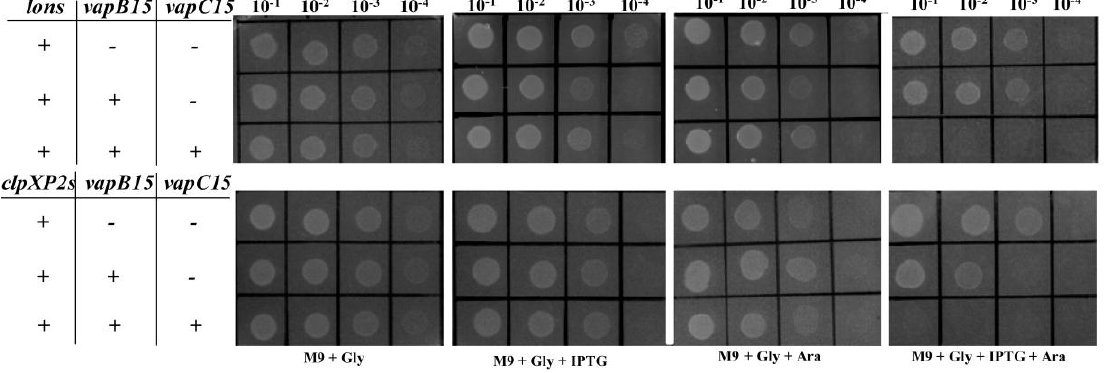
Figure 6. Drop dilution assays for the activation of VapC15 via the proteolysis of VapB10 by Lons and ClpXP2s. + or − indicates the presence or absence of the genes lons , clpXP2s , vapB15 , and vapC15 in E. coli BL(21DE3)